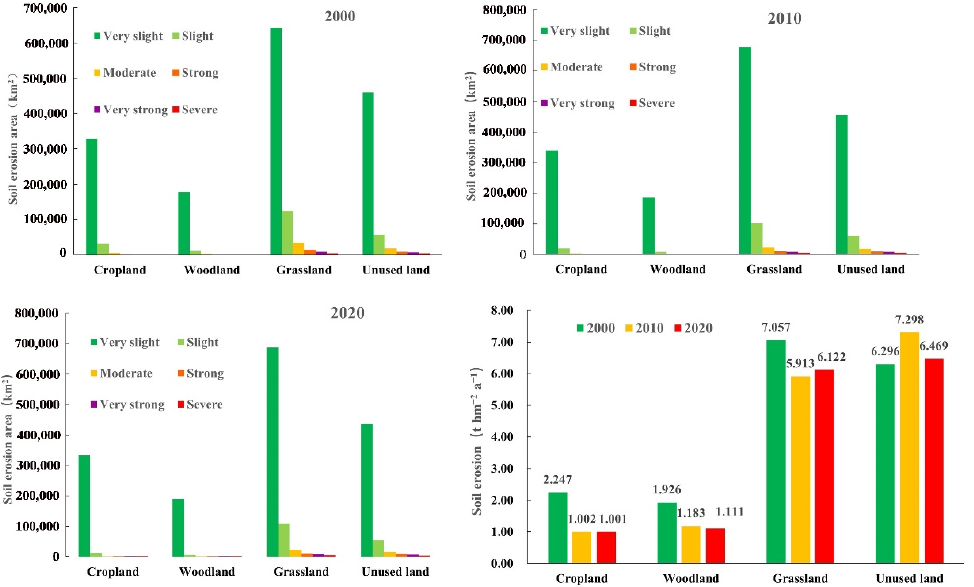
Figure 5. Soil erosion acreage and numerical value of various land-usage types between 2000 and 2020. Table 6. Proportion of different land-use areas under different soil erosion grades in the YRB from